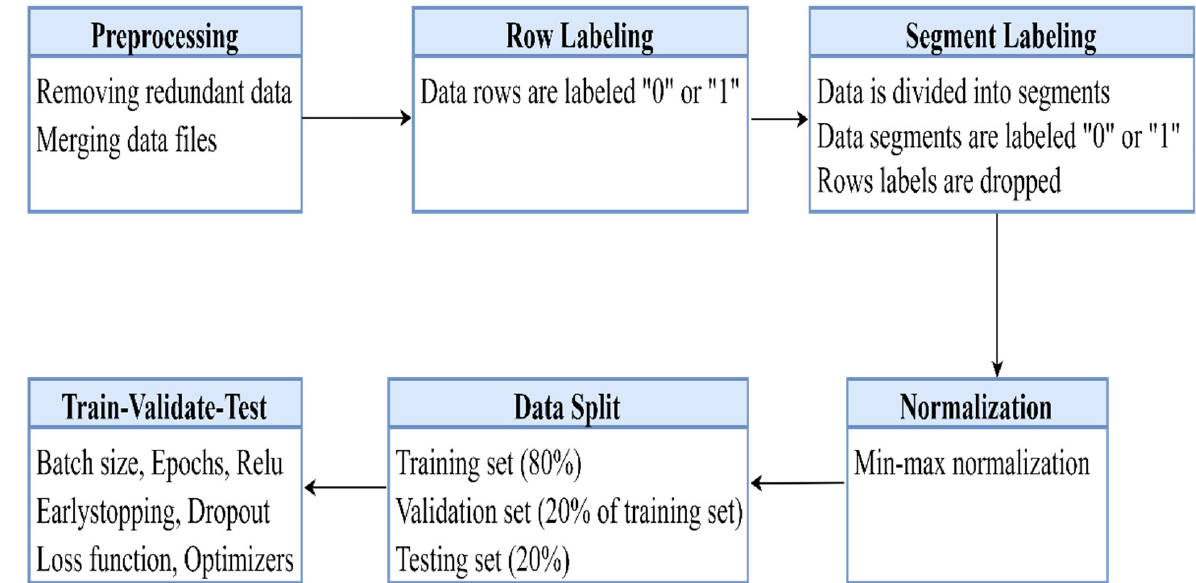
Figure 6. Proposed methodology.